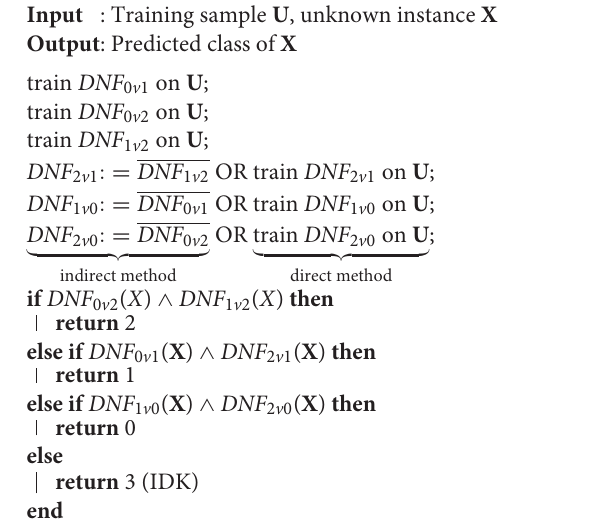
Algorithm 4 | Indirect and direct method for interpretable one-vs-one DNF classifiers using IDK-classifications.